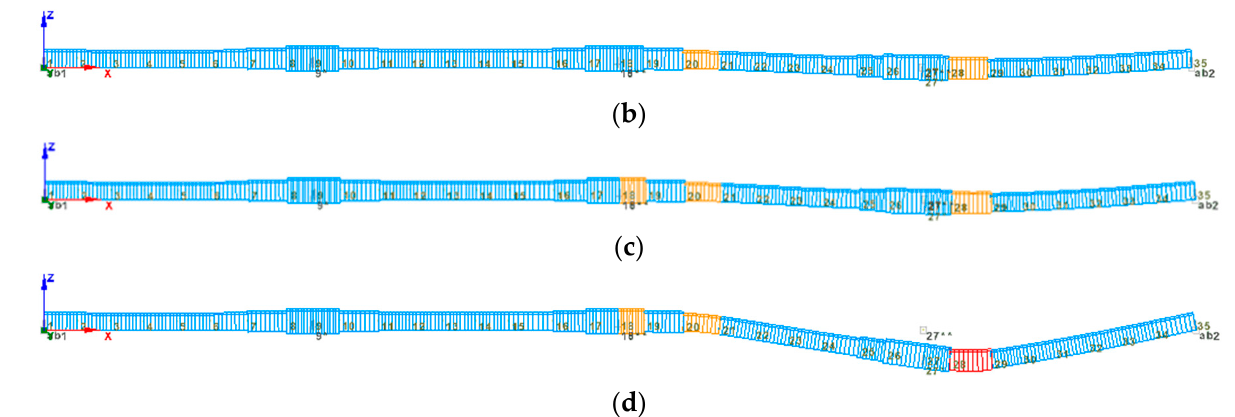
Figure 8. ( a ). Step 15: the reinforcement yield at 2.35 m from S3 pier for 0.14 m settlement of S3 pier. ( b ) Step 49: the reinforcement yield at 5.9 m from S2 pier for 0.48 m settlement of S3 pier. ( c ) Step 66: the reinforcement yield above S2 pier for 0.65 m settlement of S3 pier. ( d ) Step 72: the chord rotation capacity reached 2.35 m from S3 pier for 0.71 m settlement of S3 pier. (*, ** nodes at the bents).